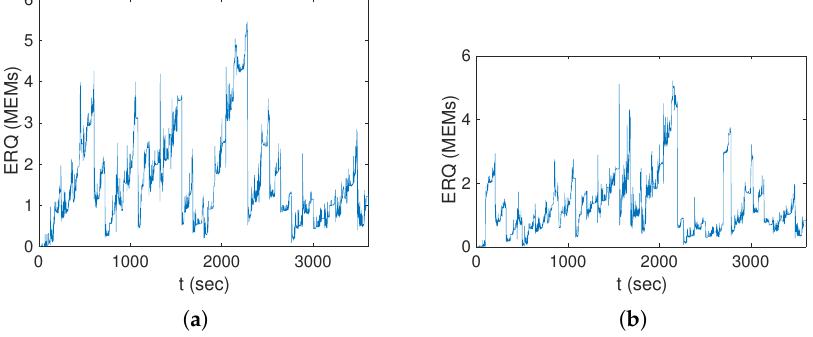
Figure 10. Temporal evolution of the exposure risk measured in MEMs. ( a ) Plaza; ( b ) Station.